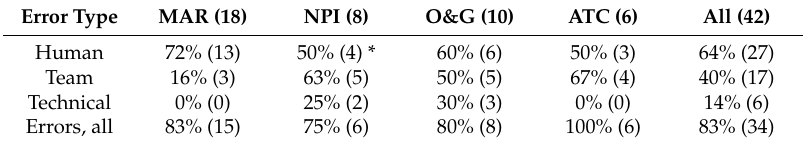
Table 5. Percentage (number) of papers that mention human, team, or technical errors per industry.